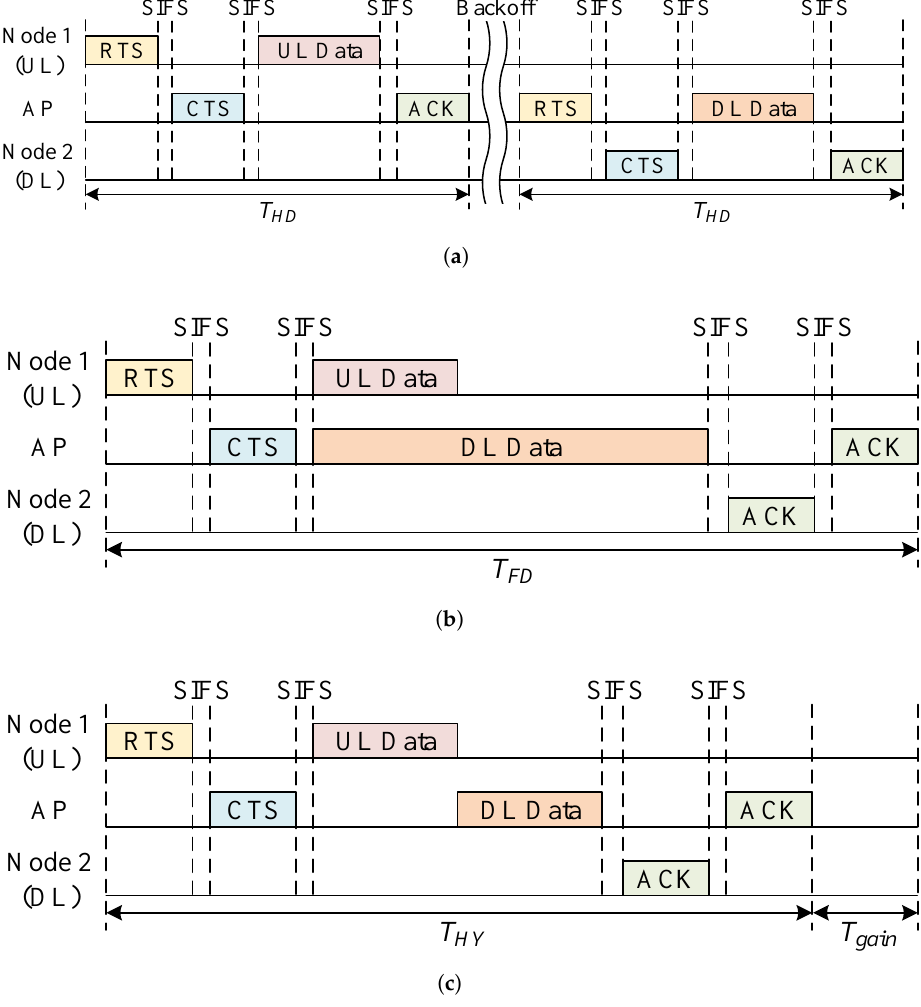
Figure 2. Examples of ( a ) HD transmission, ( b ) FD transmission, and ( c ) hybrid transmission. RTS, request to send; CTS, clear to send; SIFS, short inter-frame